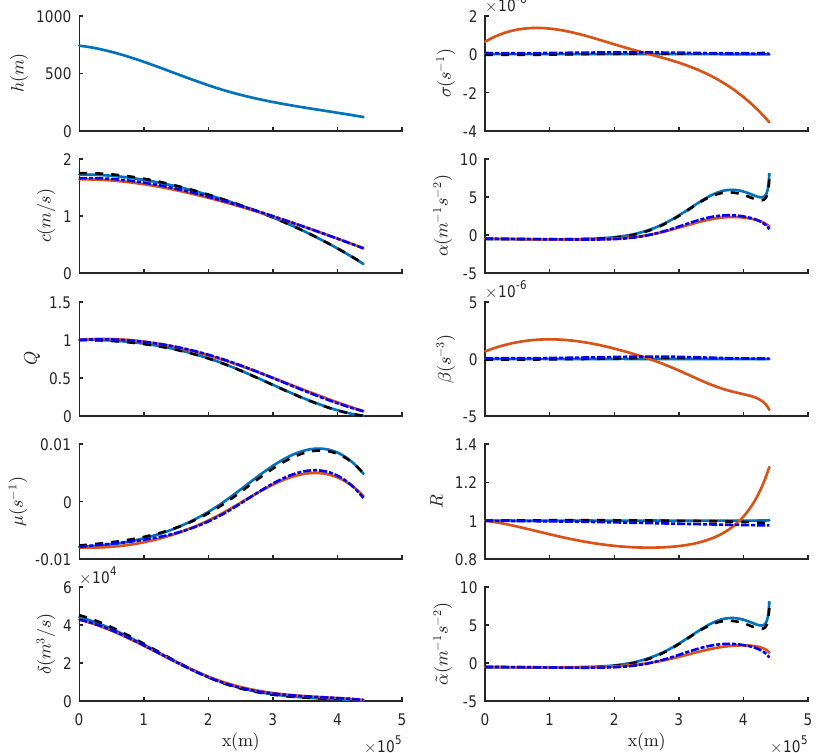
Figure 9. Variation of the original coefficients (left panel and top of the right panel) and the derived coefficients (remainder of the right panel) of the vKdV equation for conditions of the North West Shelf case. The results show the coefficients in summer with background current u 0 (blue, solid), without u 0 (black, dash) and the coefficients in winter with u 0 (red, solid), without u 0 (blue,